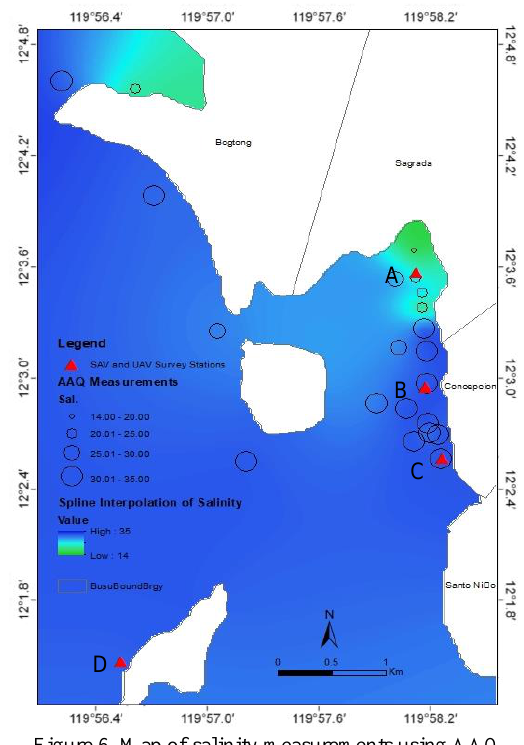
Figure 6. Map of salinity measurements using AAQ Results from the water level logger (Figure 7) deployed near Station A show the change in water pressure which indicates a diurnal tide from September 24-25, 2019 while a mixed semi- diurnal tide happened from September 26-29, 2019. This plot was already corrected for atmospheric pressure by subtracting values from a water level logger left at the surface during the